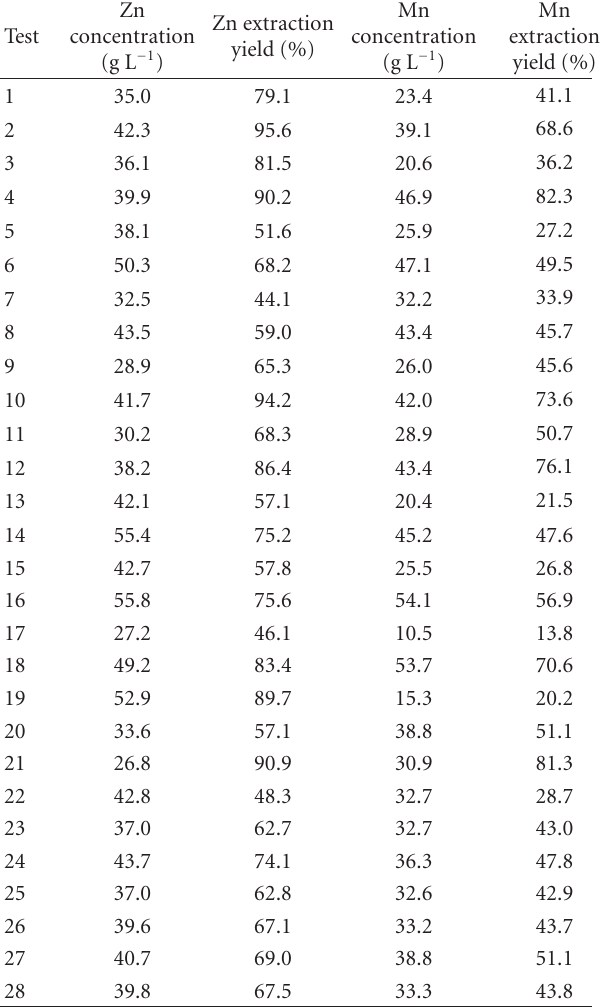
Table 7: Second series of leaching experiments: concentrations and extraction yields.